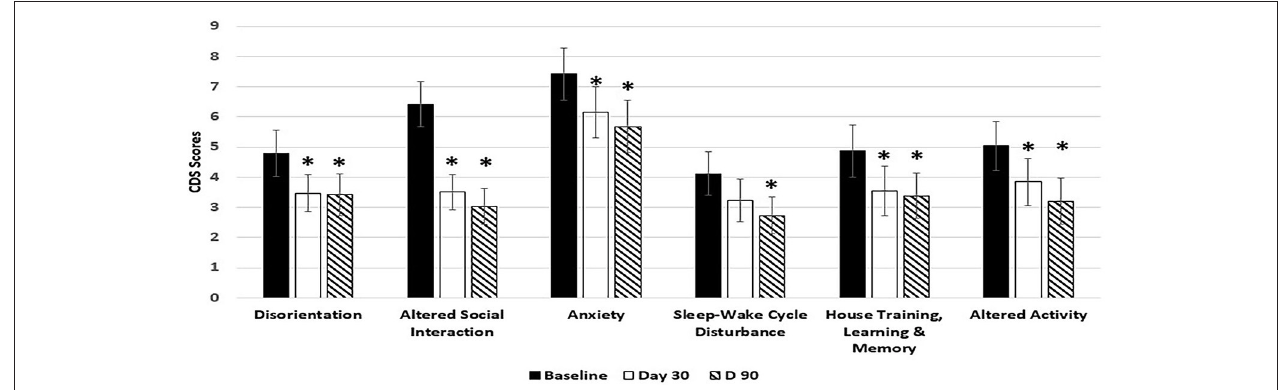
FIGURE 1 | Effects of 6.5% MCT diet on CDS signs at day 30 and day 90. Twenty-nine client owned dogs were assessed for six different behavioral signs of cognitive dysfunction syndrome (CDS) and then placed on the 6.5% MCT diet. The dogs were re-assessed after 30 days and again after 90 days. The bars illustrate Means ± SEM for each of the measures at baseline, 30 days and 90 days. Fisher Exact Probability test for multiple comparisons was used to compare baseline with day 30 and day 90. The asterisks indicate statistically significant differences ( p < 0.05) from baseline. Two dogs dropped out of the study, and one dog was removed from the study due to enrollment error.